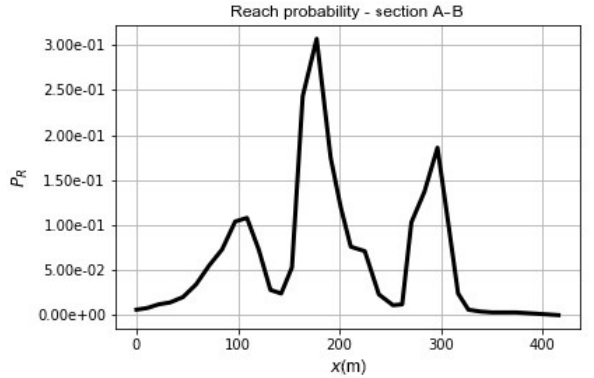
Figure 13. Reach probability along the A–B section (Fig. 12) of the A3 motorway (point A is located at x =